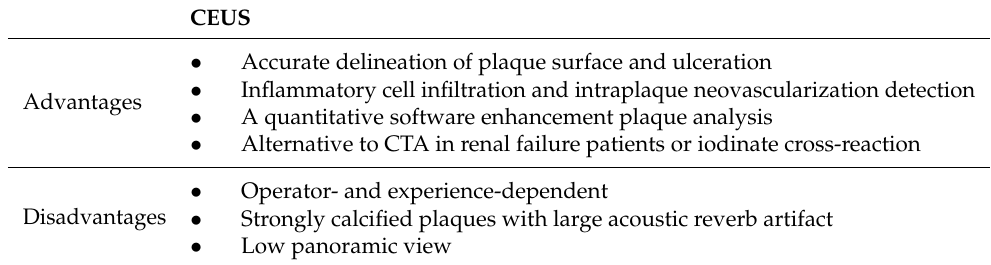
Table 2. CEUS advantages and disadvantages for the detection of carotid